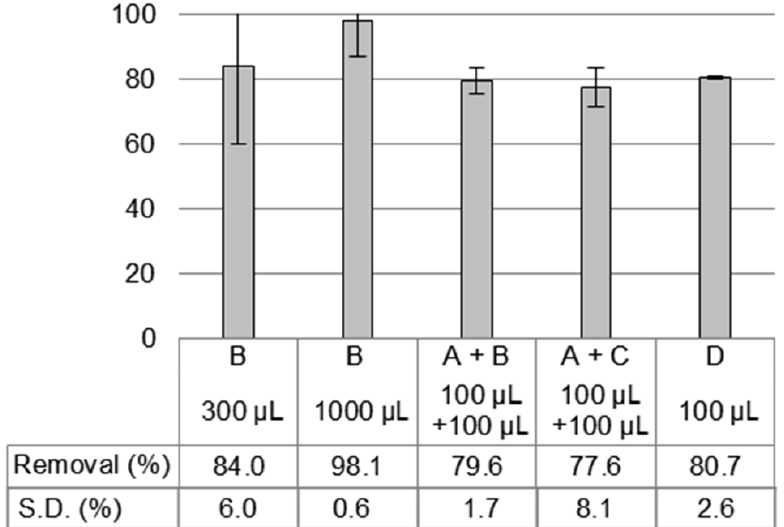
Figure 5. Removal efficiency for 100 mg PVC from 1 L demineralized water using 100 µ L organosilane at different dosages and combinations (A = PE-X; B = n-Butyltrichlorosilane; C = Isooctyltrichlorosilane; D = (3-Chloropropyl)trichlorosilane).